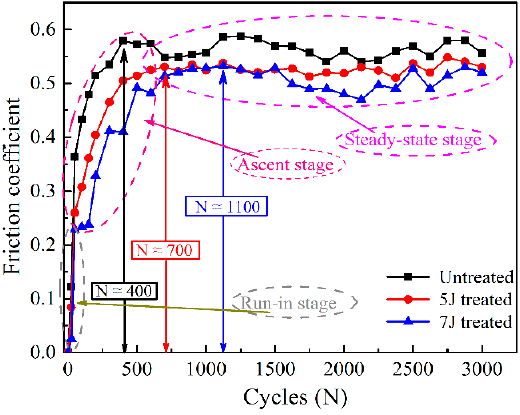
Figure 7. Friction coefficients among wear processes.